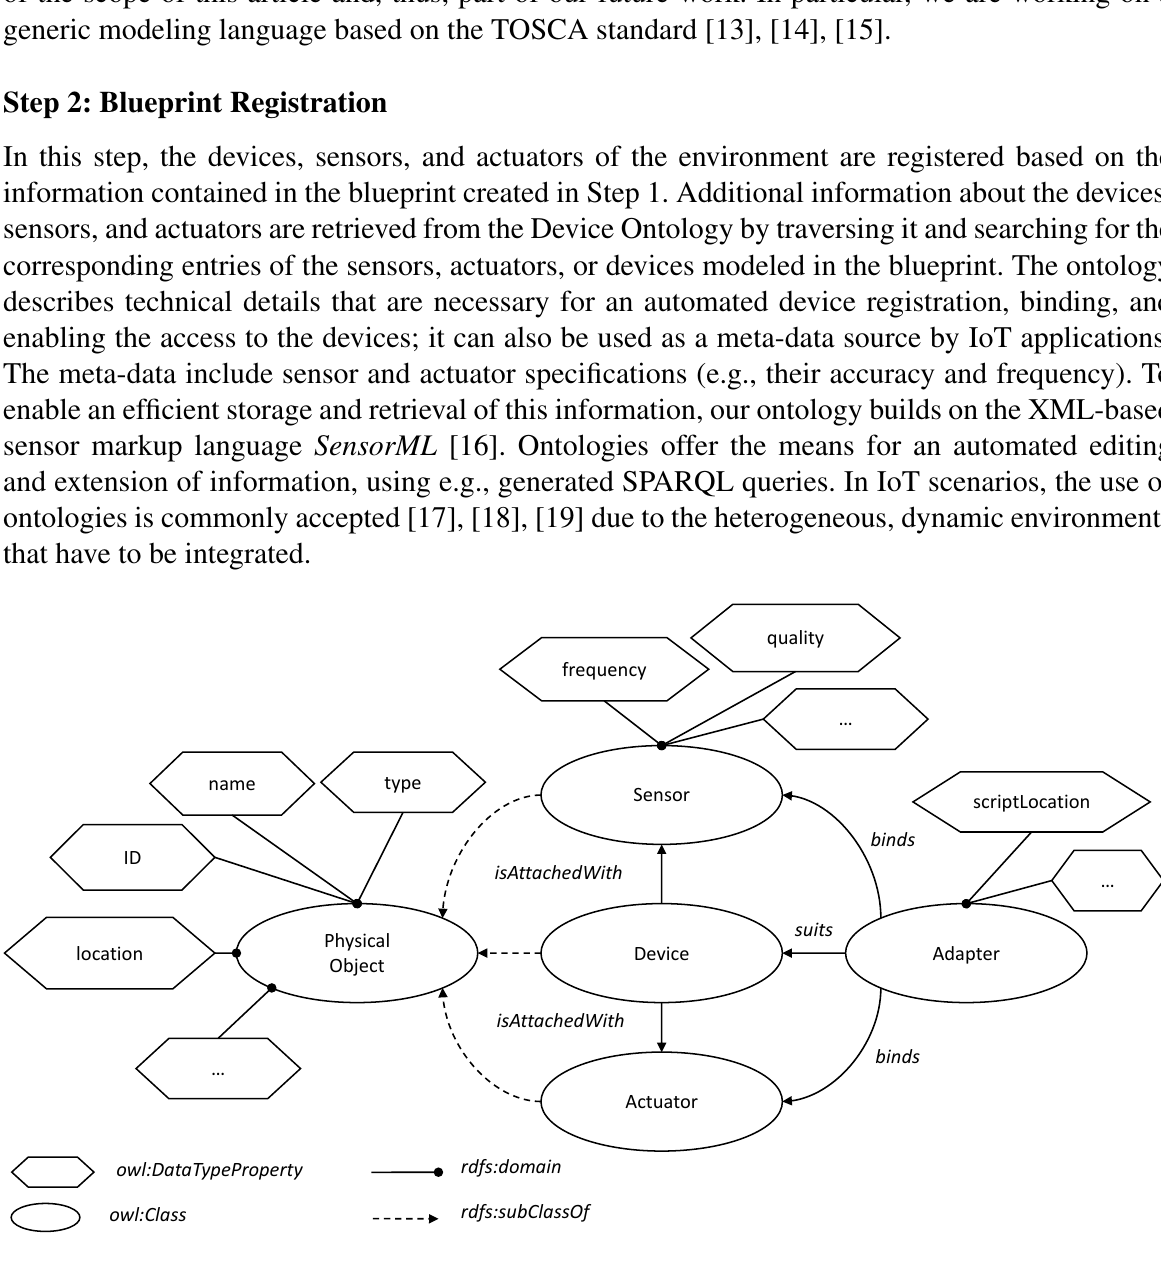
Figure 3. Condensed device ontology model (based on [11]; namespaces removed for